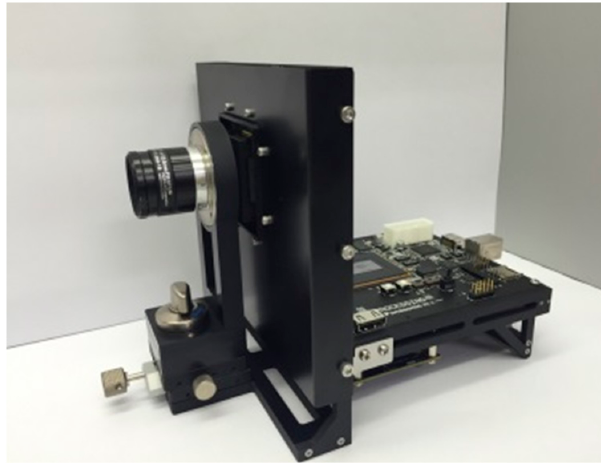
Figure 4. A photograph of the developed imaging system (camera).